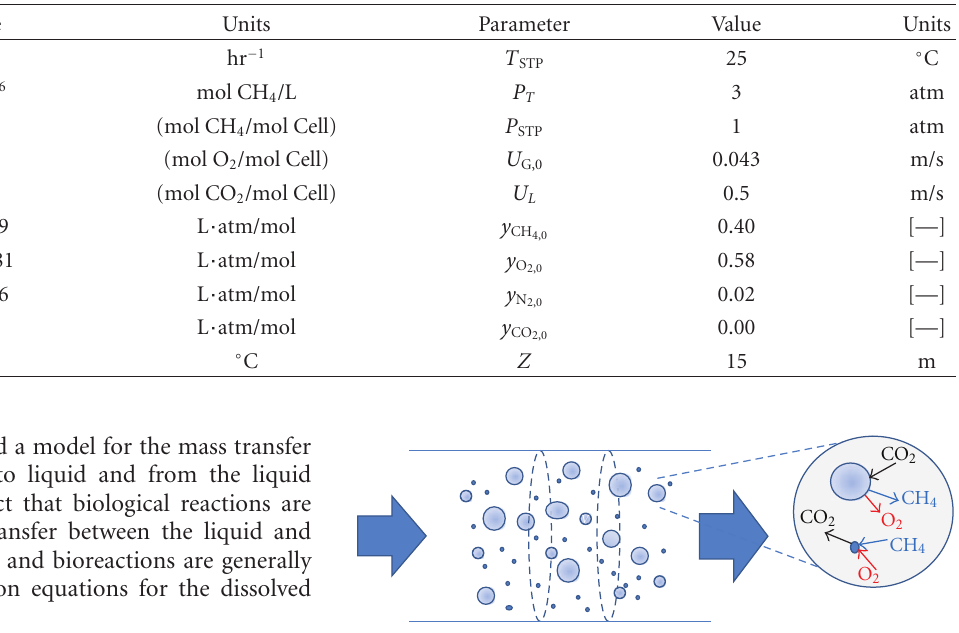
Table 1: Baseline parameters used in simulations.